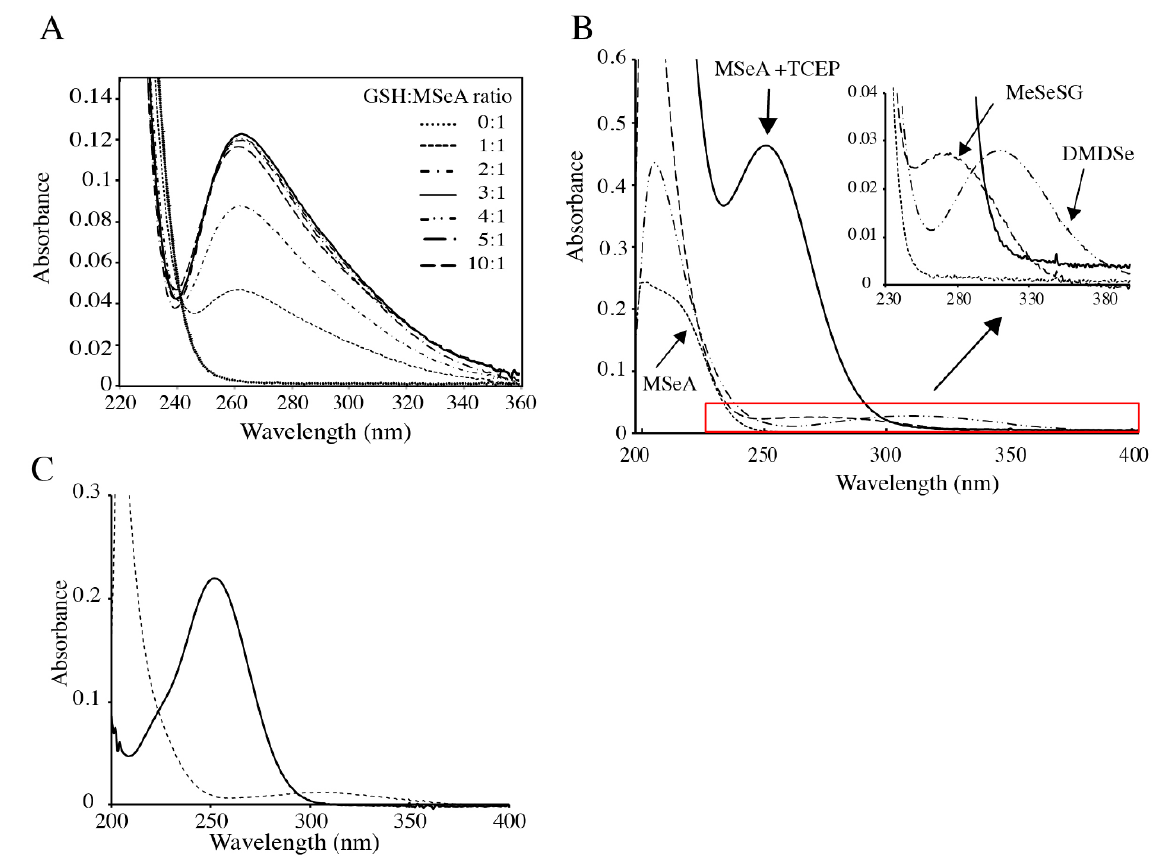
Figure 1. UV absorption spectra of various Se-containing species and effects of reducing agents. ( A ) Reduction of methylseleninic acid (MSeA) by glutathione (GSH). UV absorption spectra in 100 mM potassium phosphate, pH 7.4, of MSeA (250 µM) mixed with increasing amounts of GSH as indicated in the figure. ( B ) UV absorption spectra of various Se-containing species. The sample cuvette contained 100 µM MSeA in the absence ( ) or presence ( ) of 500 µM TCEP, 100 µM MeSeSG ( ), or 100 µM DMDSe ( ) in 100 mM potassium phosphate, pH 7.4; spectra in the red box are extended in the inset. ( C ) Reaction of MeSeSG with methylselenol (MeSeH). MeSeH was produced by mixing 25 µM DMDSe with 25 µM TCEP in 100 mM potassium phosphate, pH 7.4. UV absorption spectra were recorded before ( ) and after the addition of 50 µM MeSeSG (••••) to this sample.